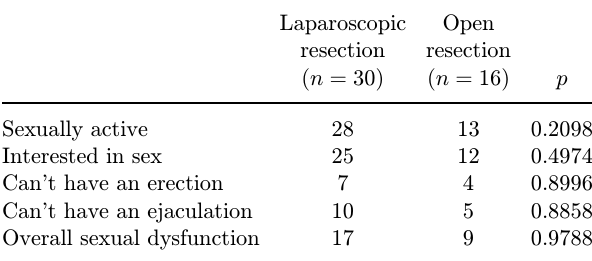
Table 5. Sexual function of male patients postoperative.